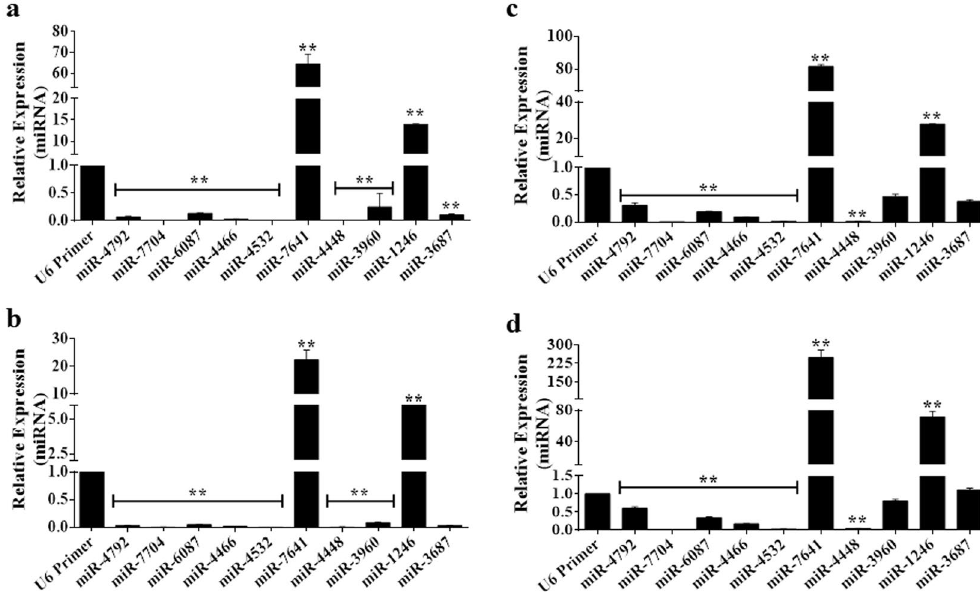
Figure 1. Expressions of 10 poorly investigated miRNAs in four cancer cell lines. ( a ) Bar diagram showing the expression levels of selected miRNAs in MCF-7 breast cancer cell line; the expression of miR-7641 was the highest followed by miR-1246, and the expression of both miRNAs were significantly ( p < 0.01) higher than the U6 control expression. ( b ) Bar chart showing the expression levels of the 10 poorly investigated miRNAs in MDA-MB-231 breast cancer cells; miR-7641 and miR-1246 had significantly ( p < 0.01) higher expression compared with the U6 control. ( c ) As shown in bar diagram, miR-7641 and miR-1246 were the highest expressed miRNAs in HT-29 colon cancer cells and their expressions were significantly ( p < 0.01) higher than that of the U6 control. ( d ) Bar diagram showing the expression of 10 miRNAs in HCT116 colon cancer cells; miR-7641 and miR-1246 were detected as the highest expressed miRNAs and were expressed significantly ( p < 0.01) higher than the U6 control. Bar diagrams presenting the mean ± SD obtained from triplicate experiments. * p < 0.05, ** p < 0.01, and *** p <